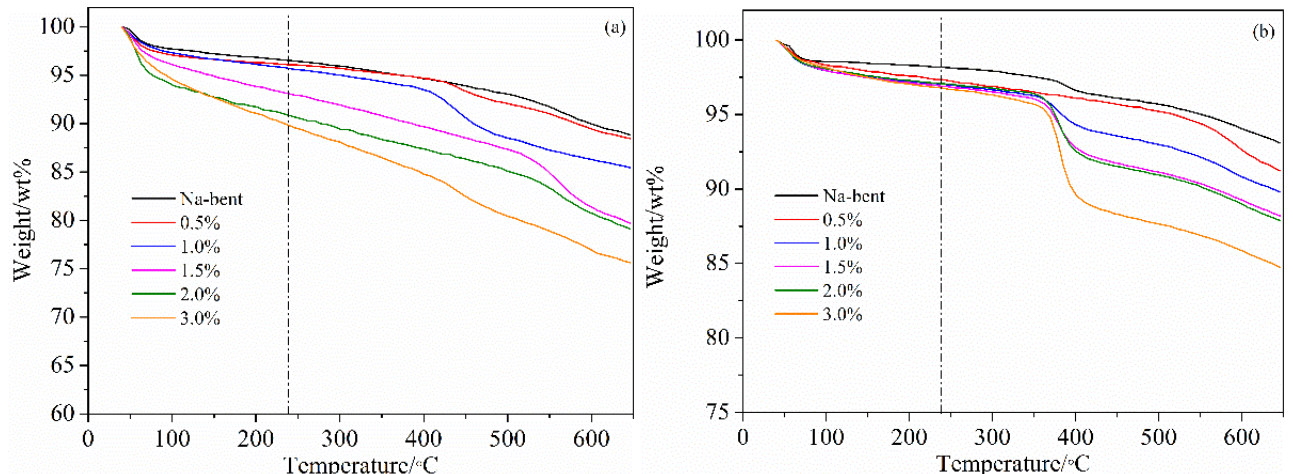
Figure 10. Thermogravimetric curve of bentonite modified by the filtrate reducer: ( a ) LDMS, ( b ), and Driscal.